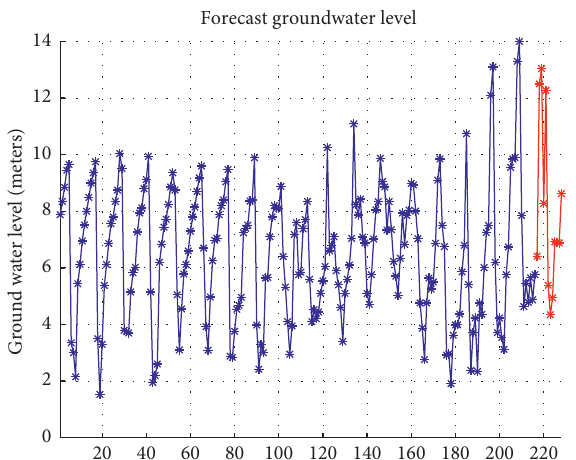
Figure 8: Plot for the forecasting groundwater